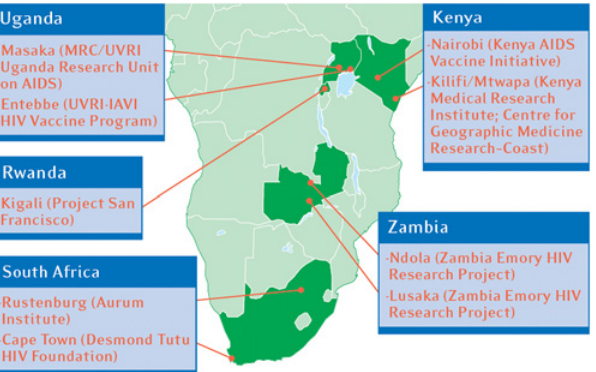
Figure 1. Map of the collaborating research centers of the IAVI Africa HIV Prevention Partnership. MRC/UVRI: Medical Research Council/Uganda Virus Research Institute, IAVI: International AIDS Vaccine